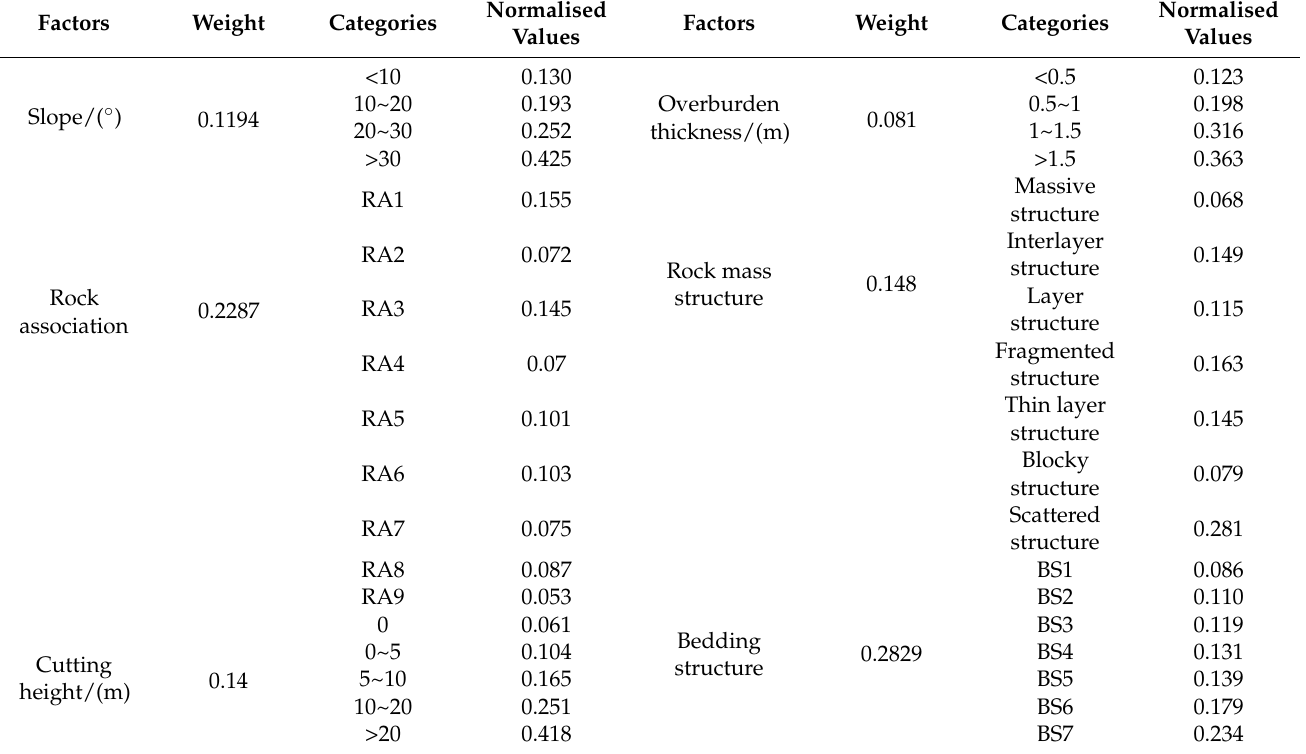
Table 6. Causal factors and grade scores of variables in AHP